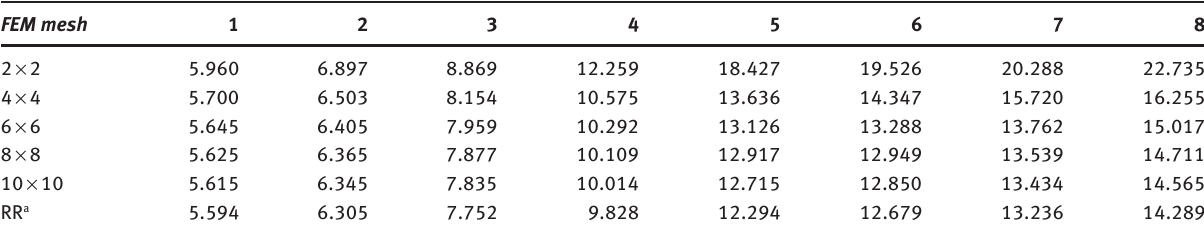
Table 6: Convergence pattern of frequency parameter λ ω π ρ = 2 2 ( ) / b FEM-PC.